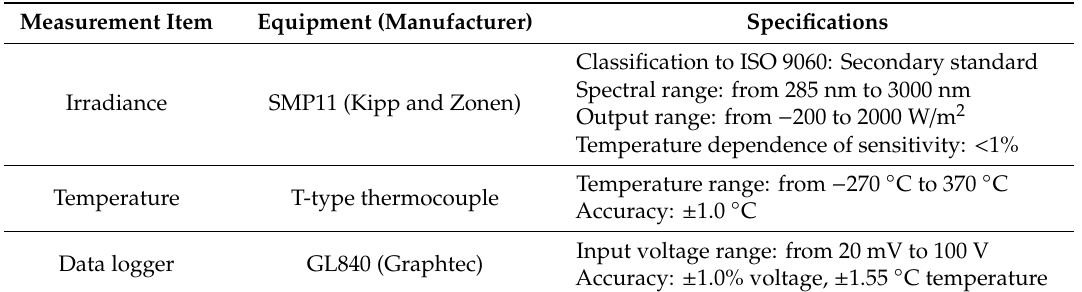
Table 4. Sensor and equipment specifications used to measure irradiance and PV